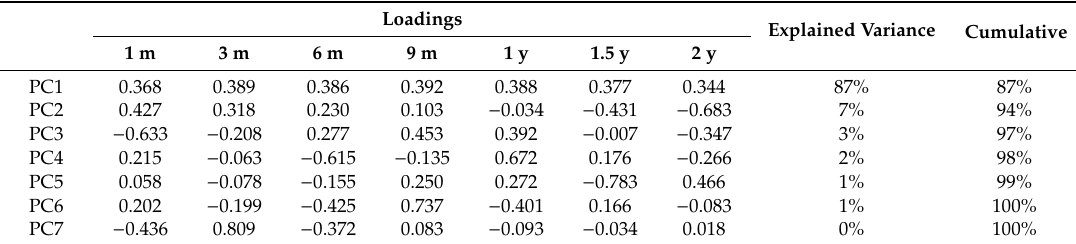
Table A1. Results from a principal component analysis of changes in expected stock returns.